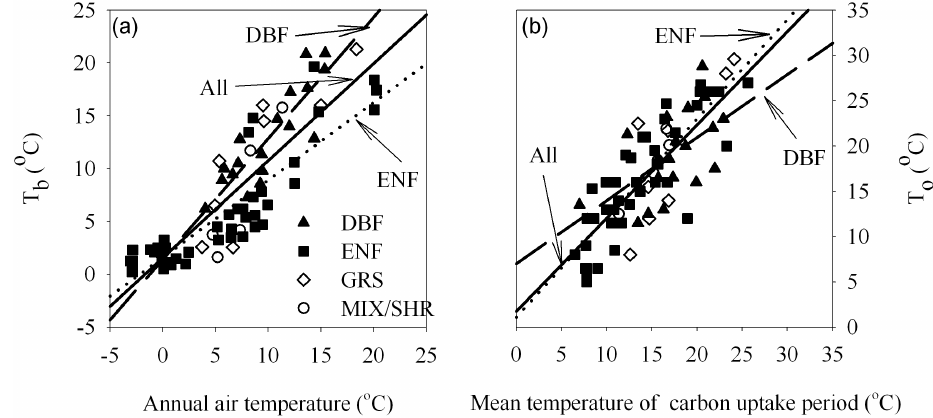
Fig. 3. The relationship between annual mean air temperature vs. T b (a) and mean temperature of carbon uptake period vs. T o (b) in deciduous broadleaf forests (DBF), evergreen needleleaf forests (ENF), grasslands (GRS), mixed forests (MIX) and Shurblands (SHR) as well as all ecosystems. T b : the transition temperature from ecosystem carbon source to sink; T o : the optimal temperature for net carbon uptake. In panel (a) , the regression lines are: y = 1 . 15 x + 1 . 41, R 2 = 0 . 81, P < 0 . 01 (DBF); y = 0 . 92 x + 1 . 57, R 2 = 0 . 73, P < 0 . 01 (All); y = 0 . 73 x + 1 . 59, R 2 = 0 . 77, P < 0 . 01 (ENF). At (b) , y = 0 . 69 x + 7 . 02, R 2 = 0 . 32, P < 0 . 05 (DBF); y = 1 . 02 x + 1 . 76, R 2 = 0 . 64, P < 0 . 01 (All); y = 1 . 09 x + 1 . 09, R 2 = 0 . 71, P < 0 . 01 (ENF).